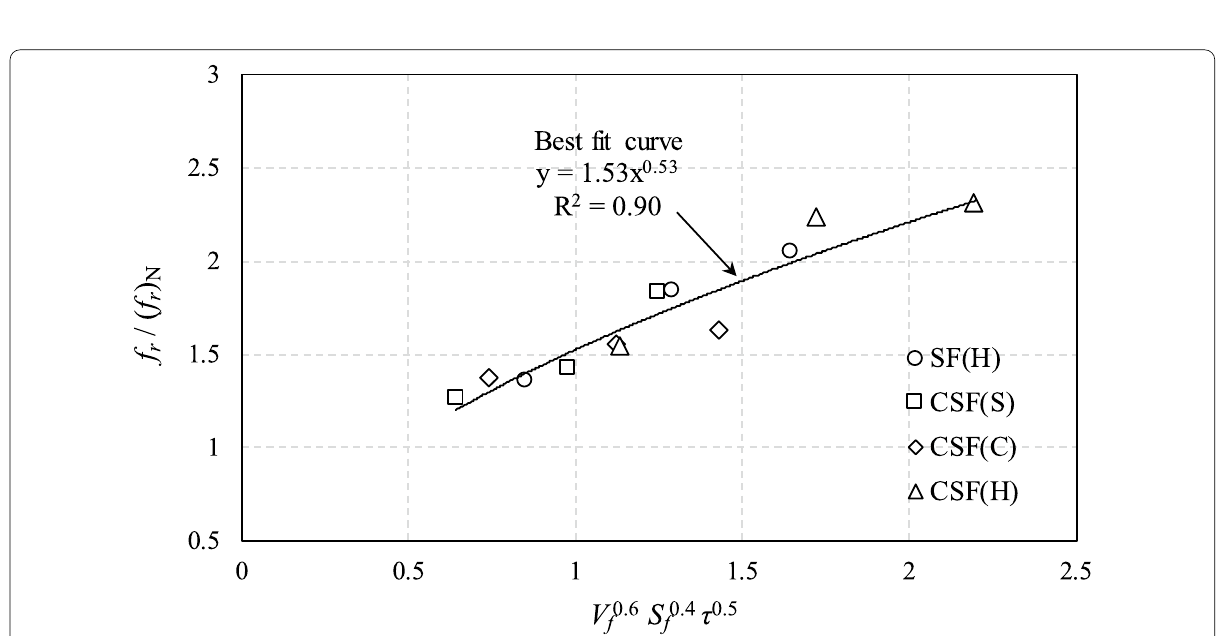
Fig. 11 Modulus of rupture according to the volume fraction of fibers.